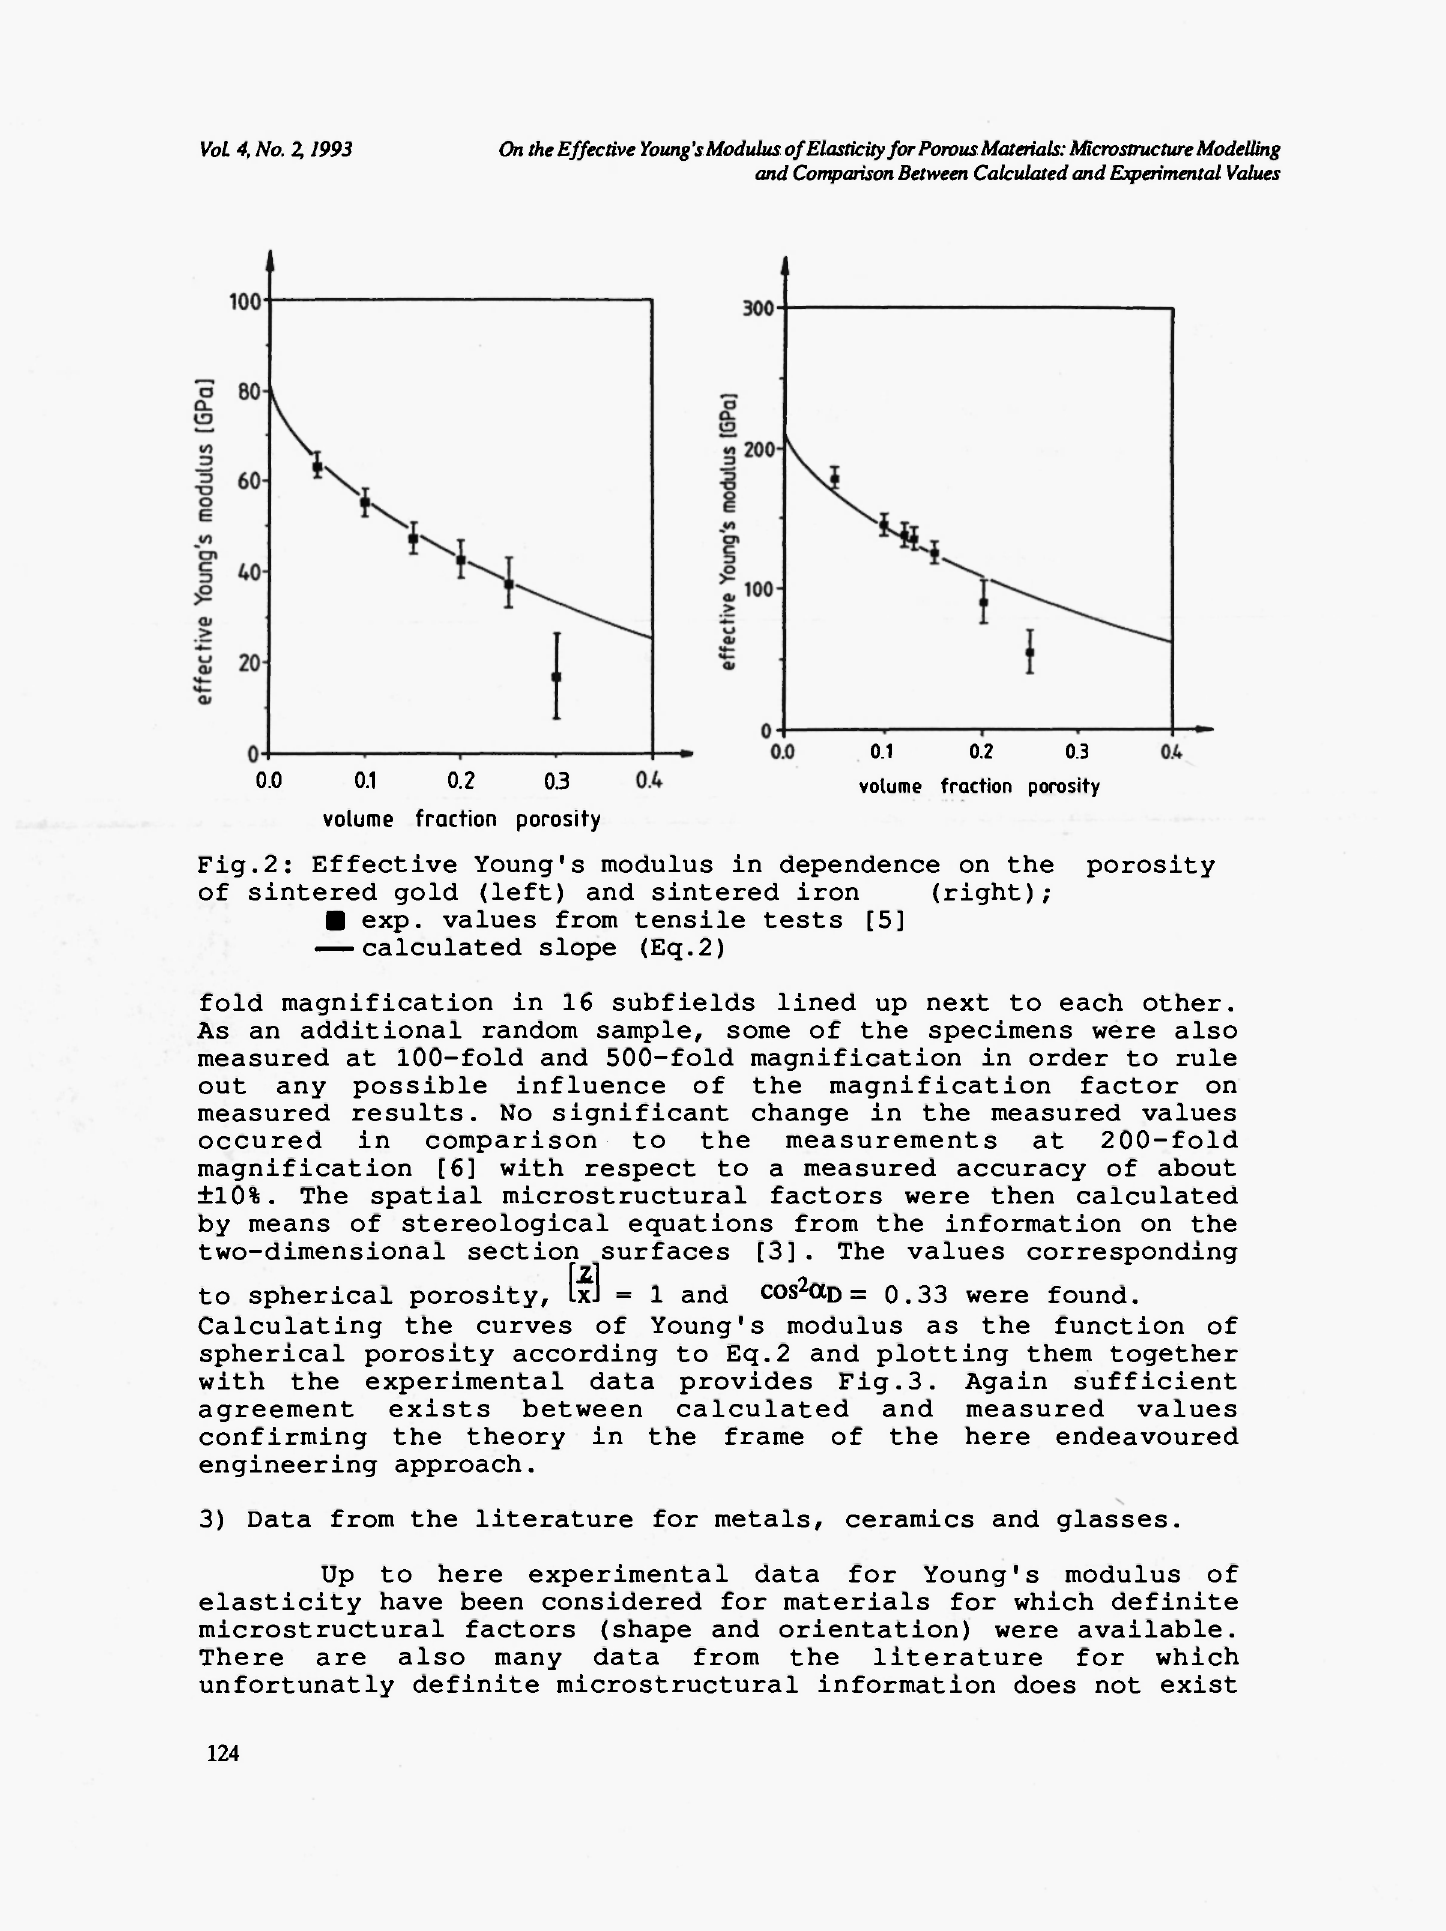
for of factors (shape and orientation) were